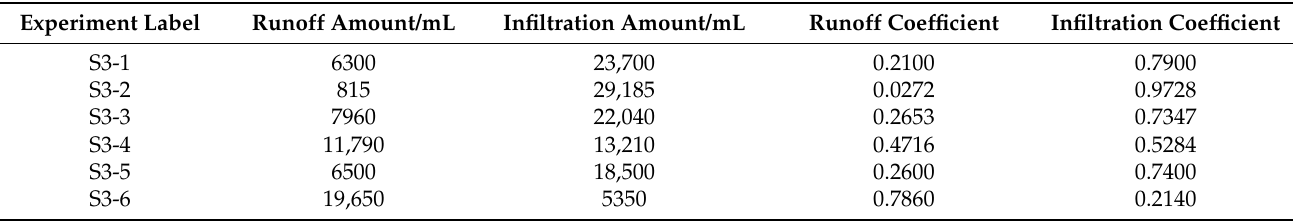
Table 3. Runoff and infiltration